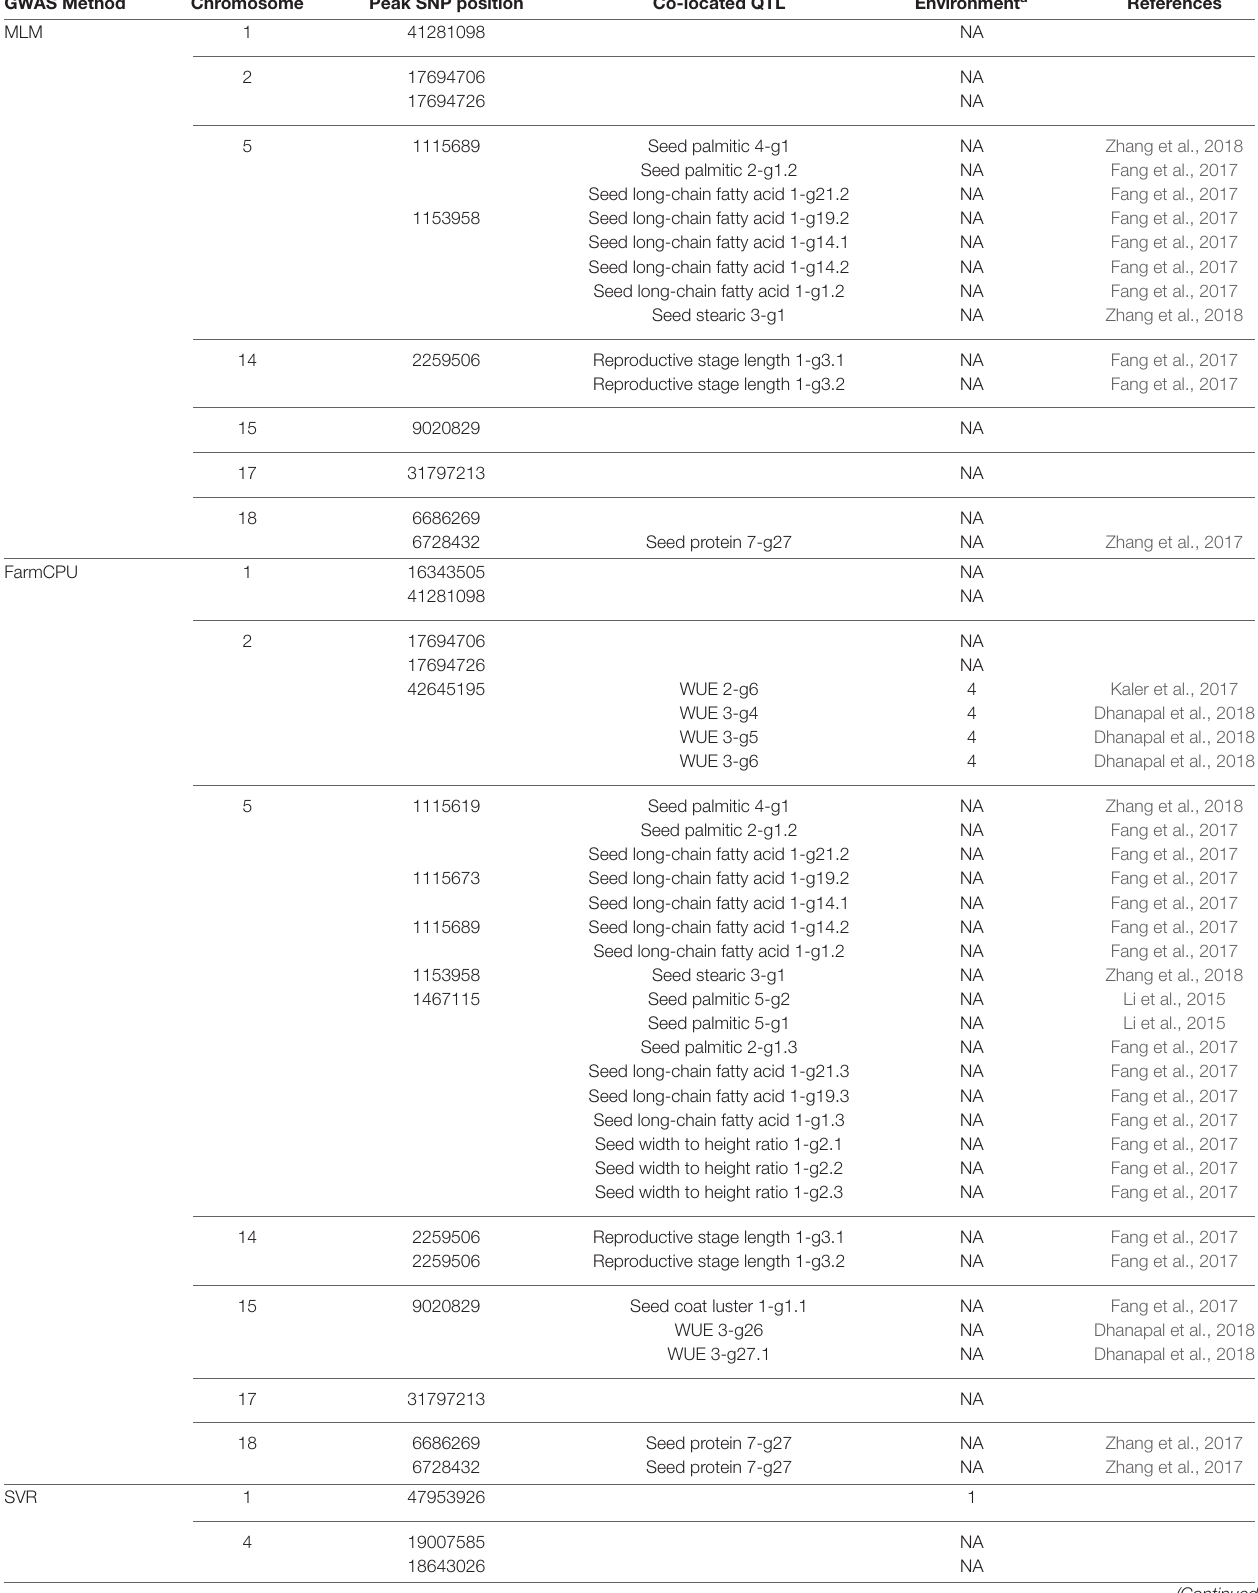
TABLE 4 | The list of detected QTLs for 730 nm using different GWAS methods in the tested soybean panel. GWAS